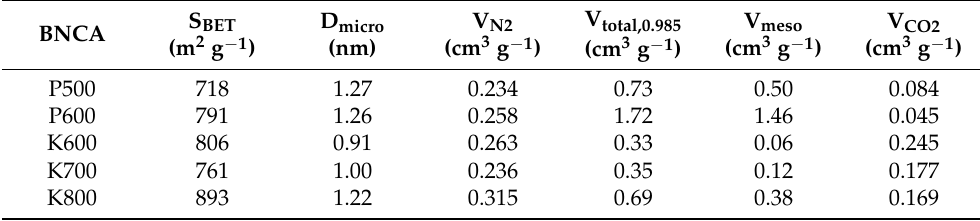
Figure 3. SEM micrographs at ×50,000 of BNCA-K ( a ) at 600 °C ( a , b ), at 700 °C ( c , d ), and at 800 °C ( e , f ). Table 1. Structural properties of